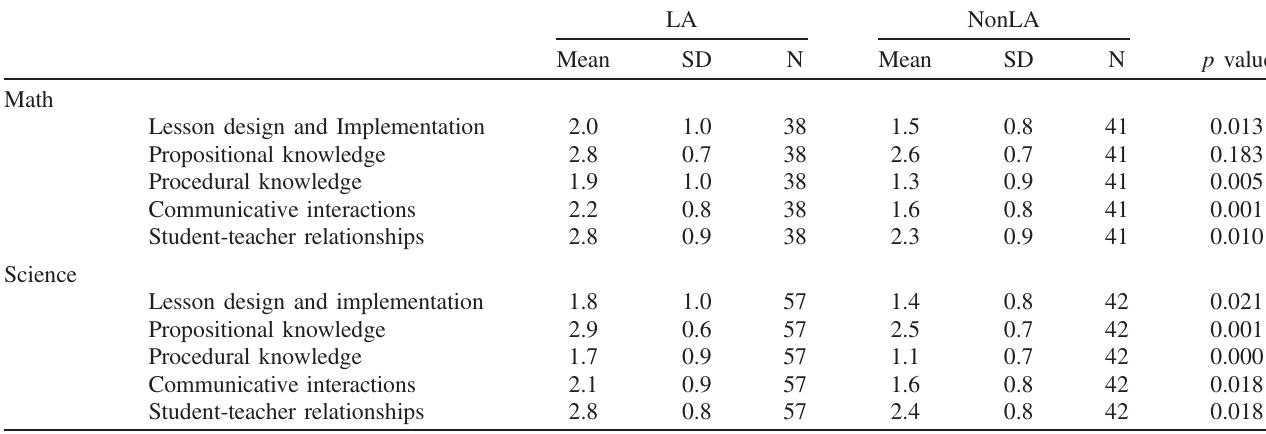
TABLE IV. Average statement response for the five categories of the RTOP.